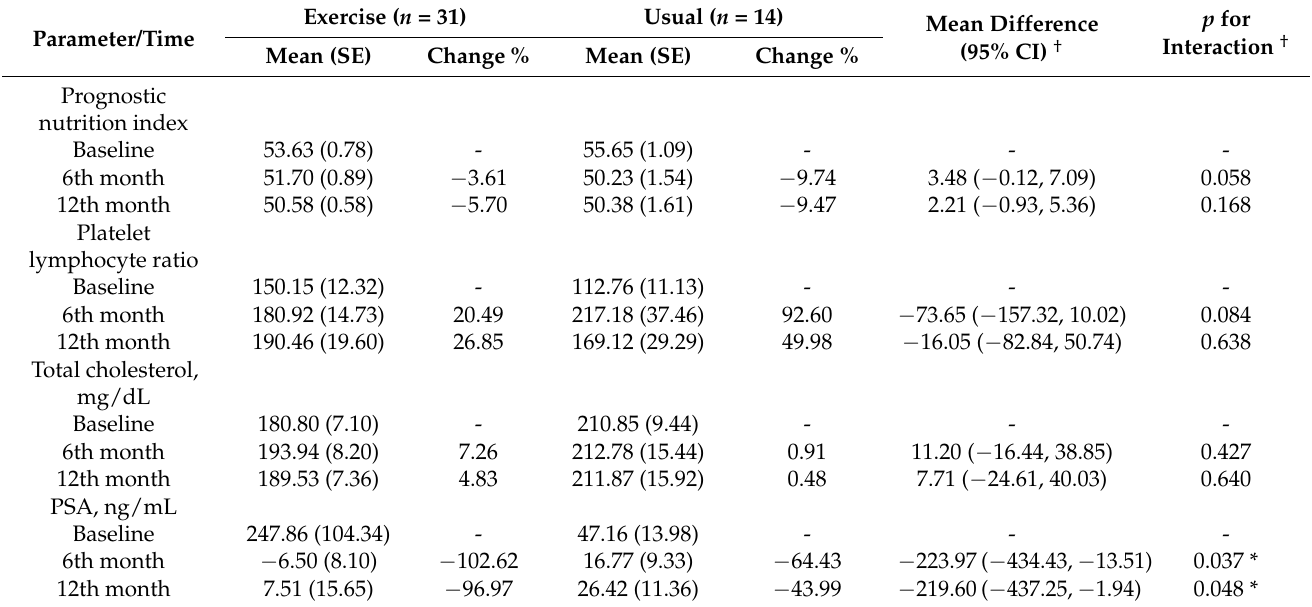
Table 4. The comparison of laboratory examinations between the exercise and usual